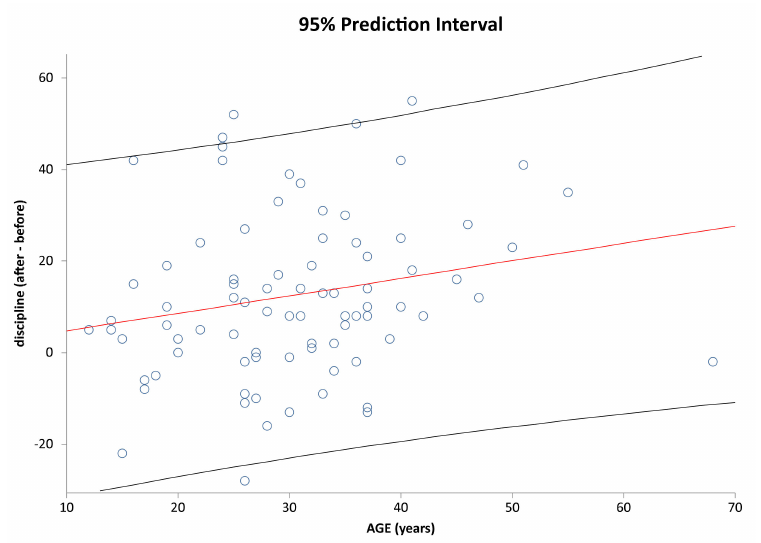
Figure 8. Prediction interval and linear regression line for Discipline (after-before) vs. Age in the investigated sample (r = 0.210; p = 0.0528). Regression line and 95% prediction interval are denoted as in Figure